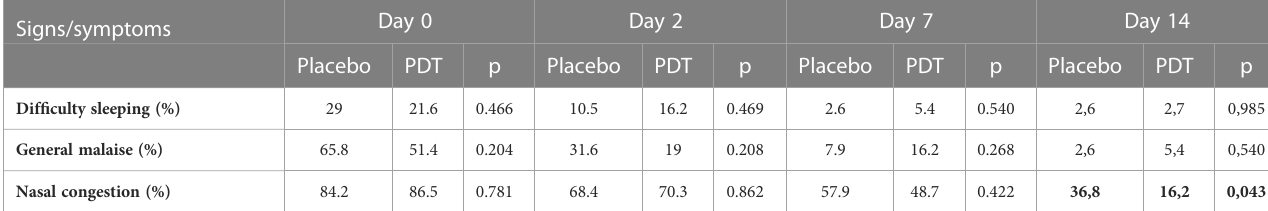
SUPPLEMENTARY TABLE 1 Antibody assays. SUPPLEMENTARY TABLE 2 T Cell immunity assays. SUPPLEMENTARY FIGURE 1 Phylogeny of viral species from patients ’ samples. SUPPLEMENTARY FIGURE 2 Local ENT adverse effects during the clinical